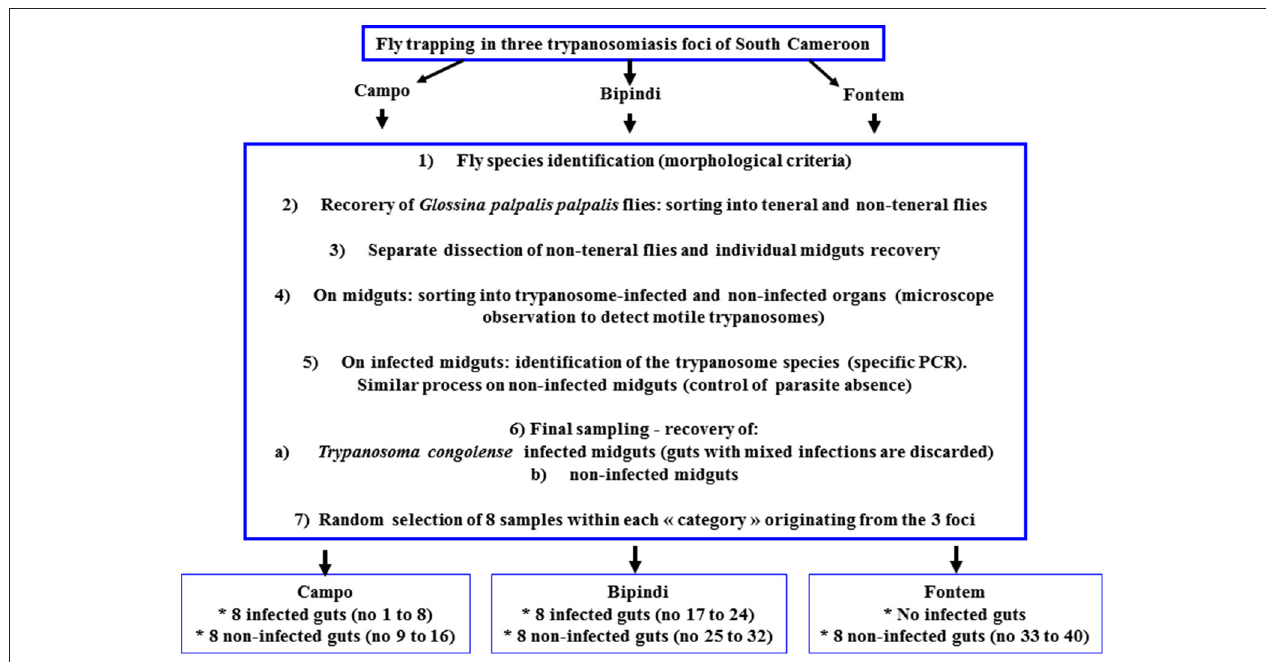
FIGURE 2 | Glossina sampling and selection